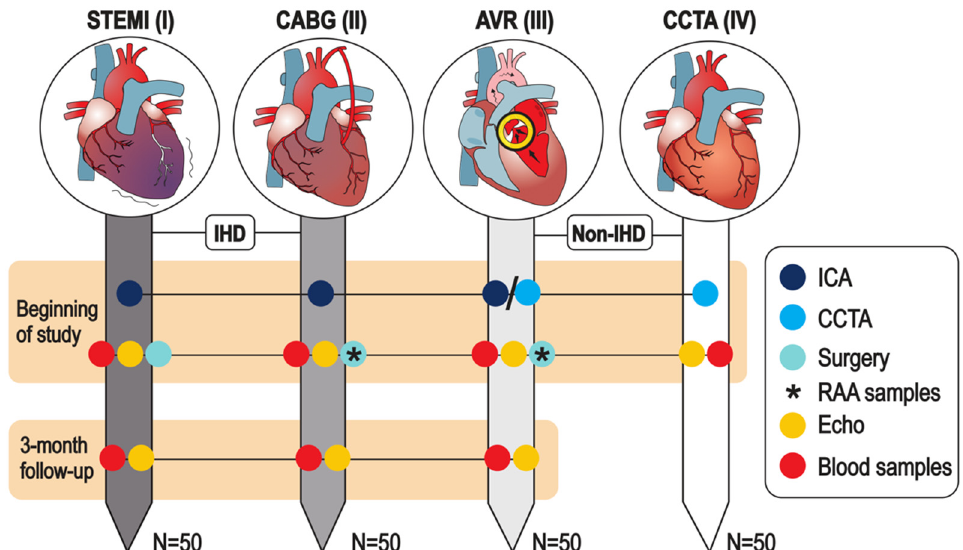
Figure 3. Outline and sample collection in the IHD-EPITRAN study. The gray scale provides an arbitrary scale for disease severity across cohorts. STEMI , ST-elevation myocardial infarction; CABG , coronary artery bypass grafting; AVR , aortic valve replacement; CCTA , coronary computed tomography angiogram; ICA , invasive coronary angiography; RAA , right atrial appendage; IHD , ischemic heart disease.